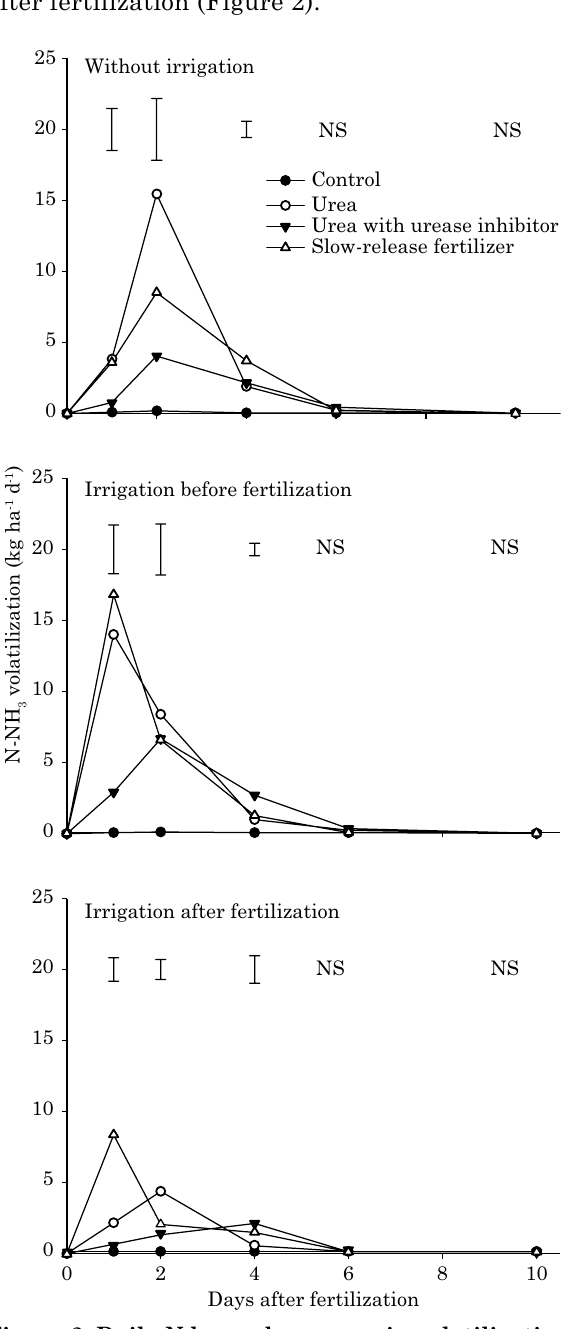
figure 2. daily n losses by ammonia volatilization from different n fertilizers applied without irrigation, irrigation immediately prior to fertilization and fertilization immediately after irrigation. Vertical bars indicate the least significant difference, according to the Tukey test at 5 %. NS: not